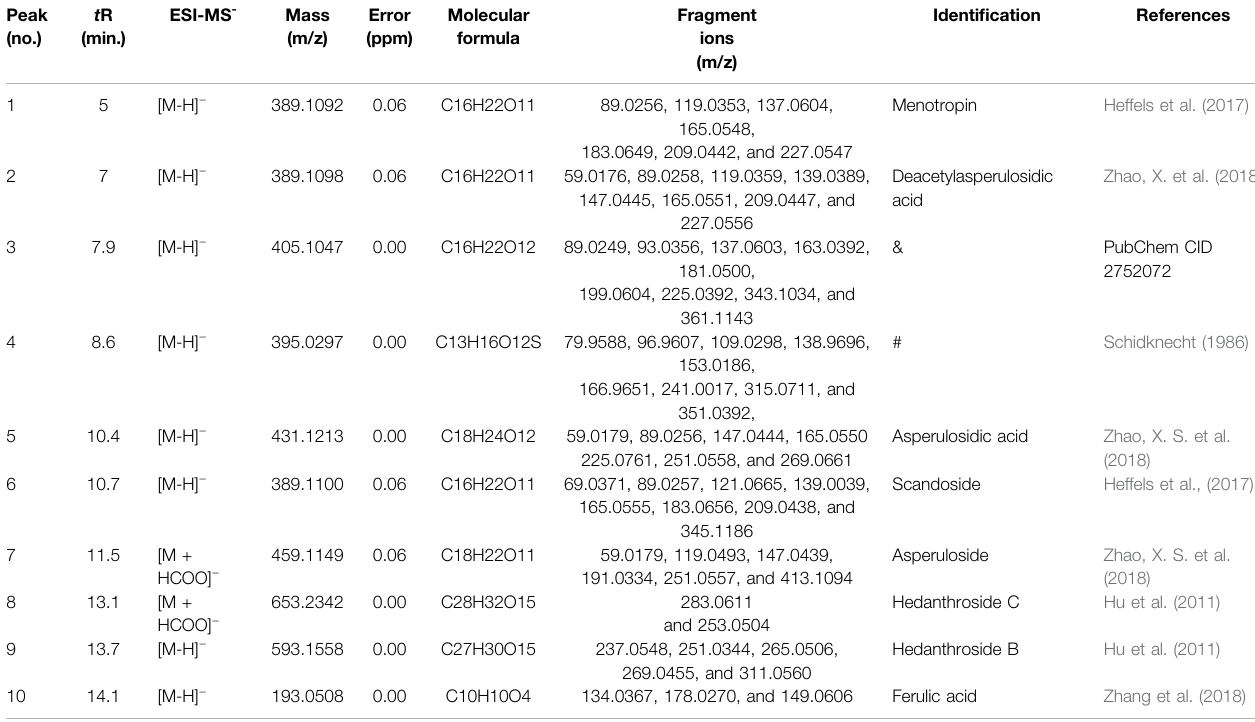
TABLE 2 | Characterization of the chemical constituents of OH by using UHPLC-MS and UHPLC-Triple-TOF-MS. Peak